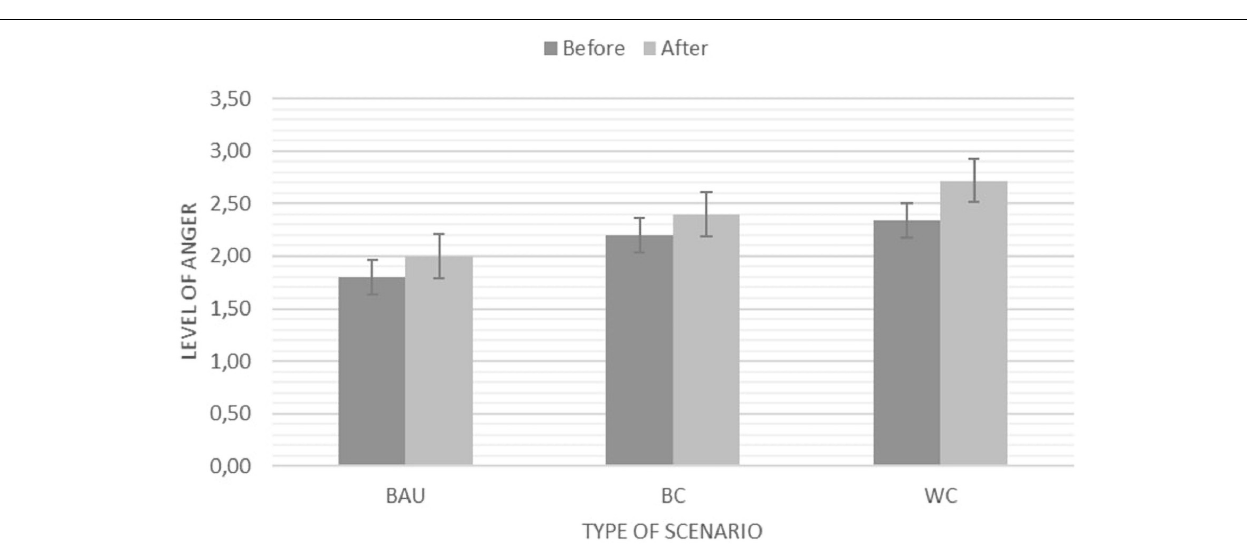
FIGURE 10 | Significant main effect for the feeling of anger before and after engaging with one of the three scenarios (BAU, Business as Usual; BC, Best Case Scenario; and WC, Worst Case Scenario). NB: Y -axis adapted for illustration purposes. The Likert scale ranges from 1 ( Strongly disagree ) – 5 ( Strongly agree